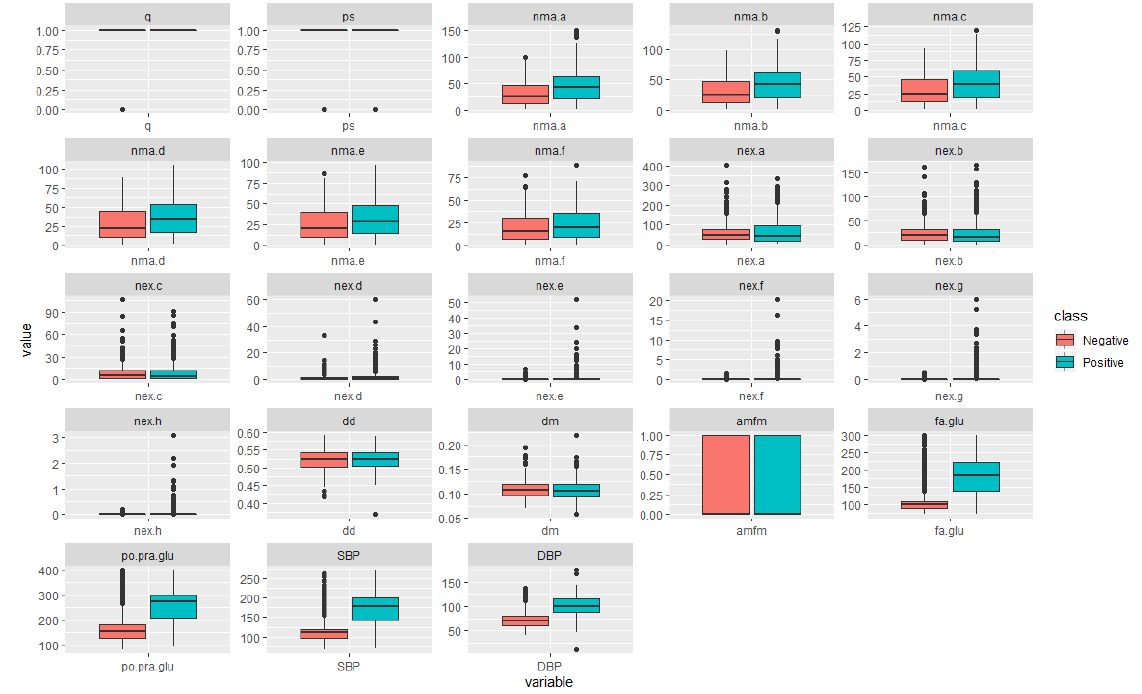
Figure 5. Box plot of